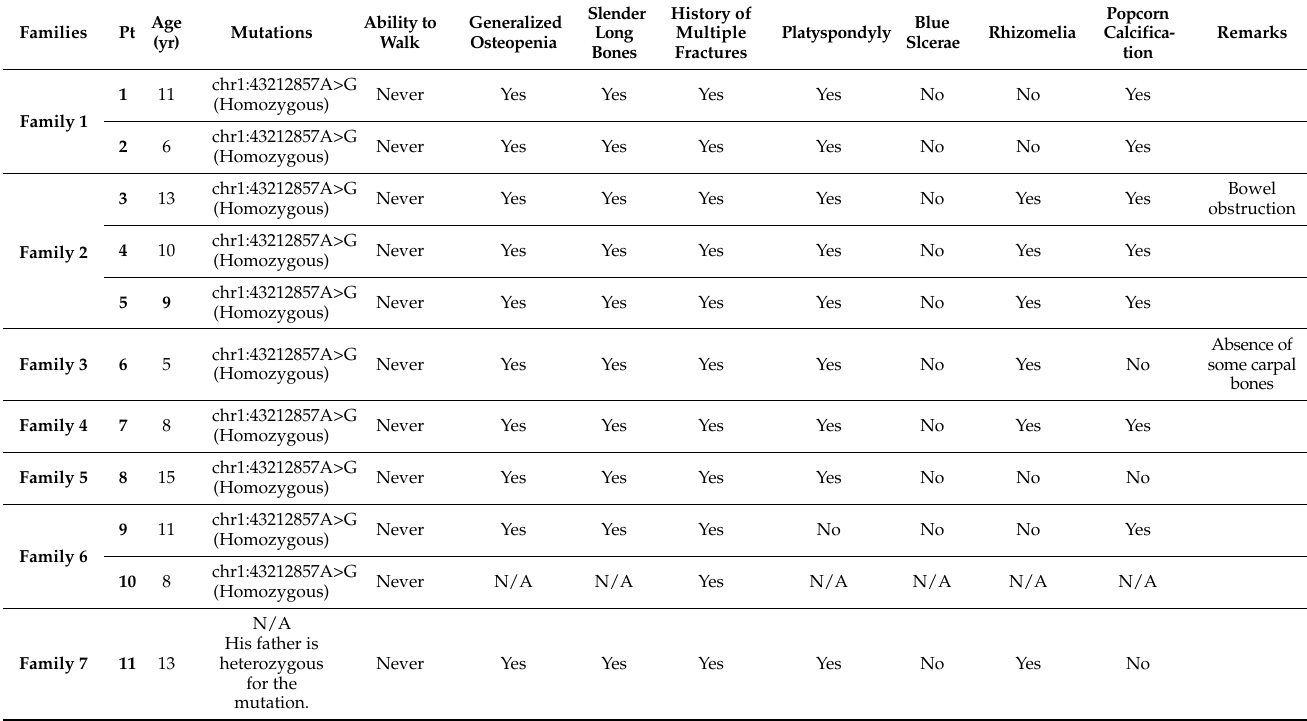
Table 1. Clinical, radiographic, and molecular findings in patients